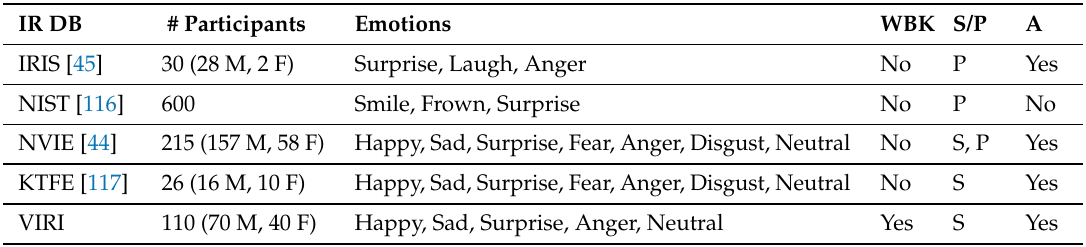
Figure 3. Sample visible and IR image (VIRI) in Multi-Spectral Dynamic Imaging (MSX) and visible format. Table 2. Comparison of the available IR DBs and VIRI. WBK: Wild Background, S/P: Spontaneous/Posed, A: